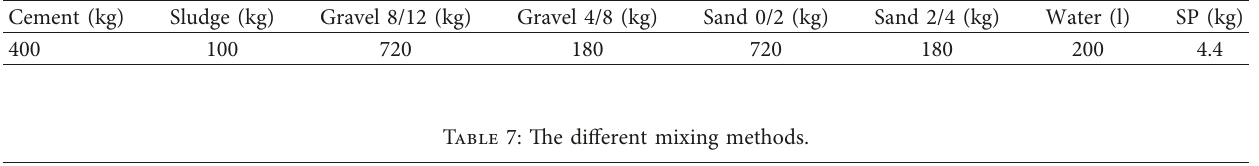
Table 6: Composition of 1m 3 of SCC with marble sludge.